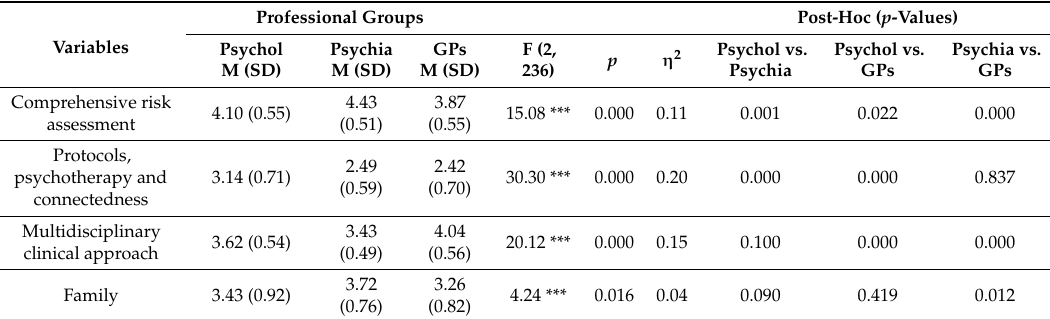
Table 3. Differences in practice components according to professional